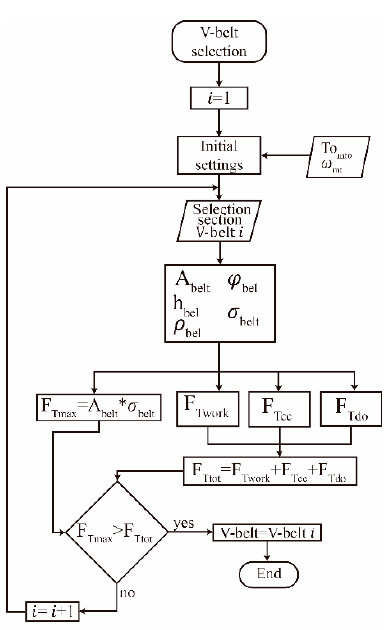
Figure 3. Belt selection flowchart.